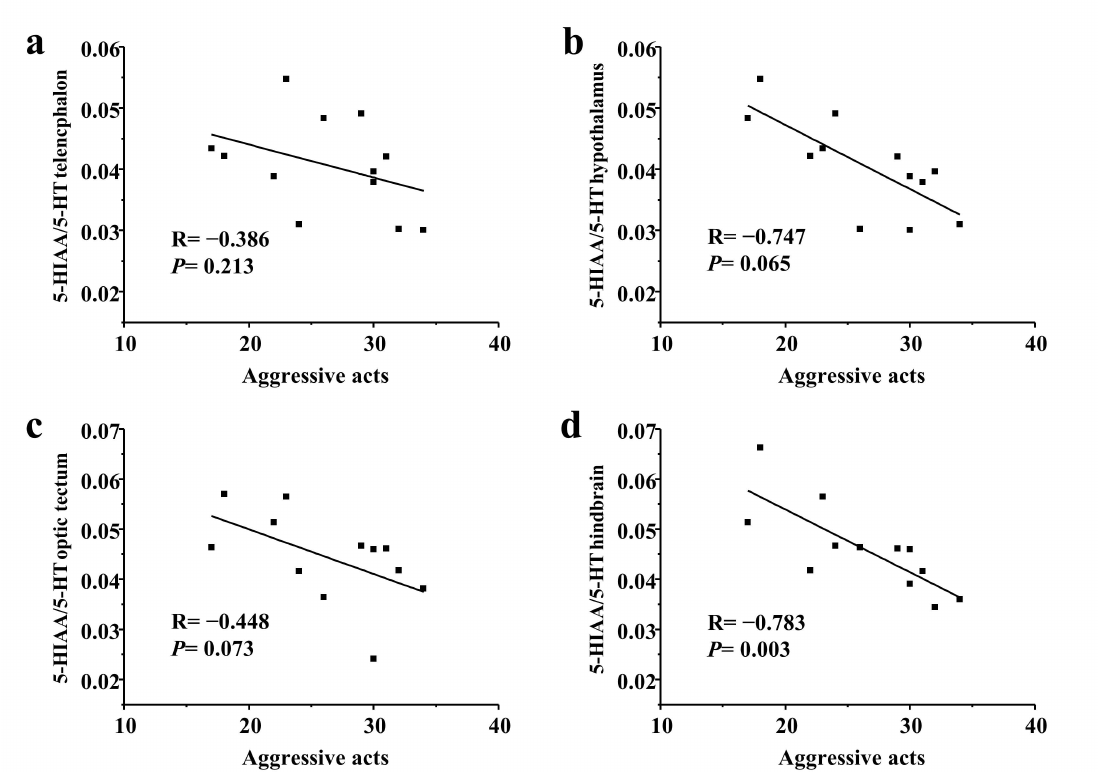
Figure 5. Relationship between aggressive acts and 5-HIAA / 5-HT ratios of subordinate black rockfish in ( a ) telencephalon, ( b ) hypothalamus, ( c ) optic tectum, and ( d ) hindbrain after a long-term contest. Spearman R and p values are